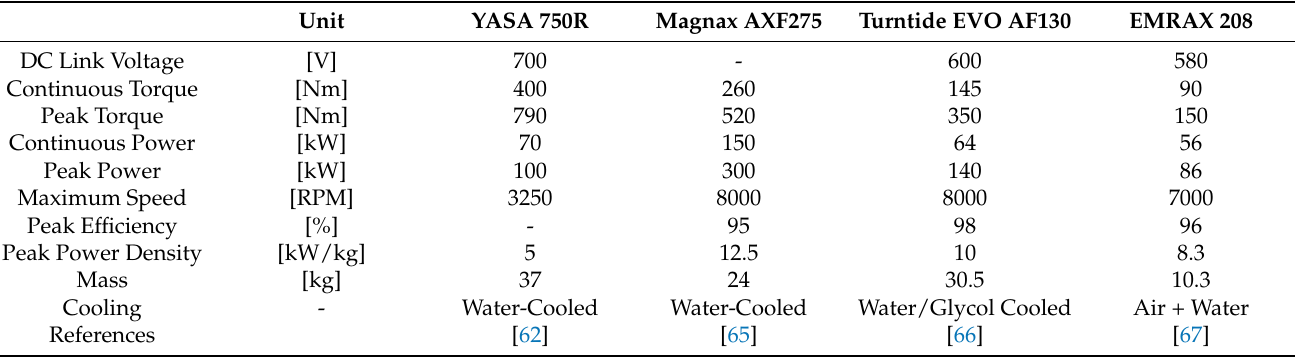
Table 3. Comparison of commercial radial flux motor with permanent magnets.